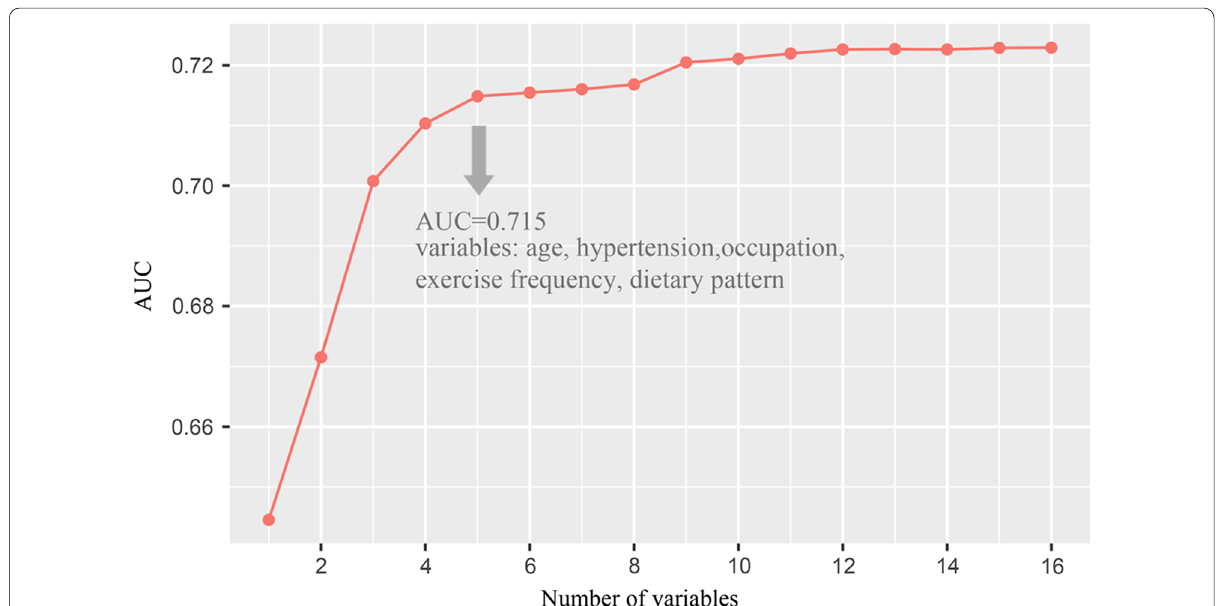
Fig. 4 AUC values for Random Forest models in the stepwise selection